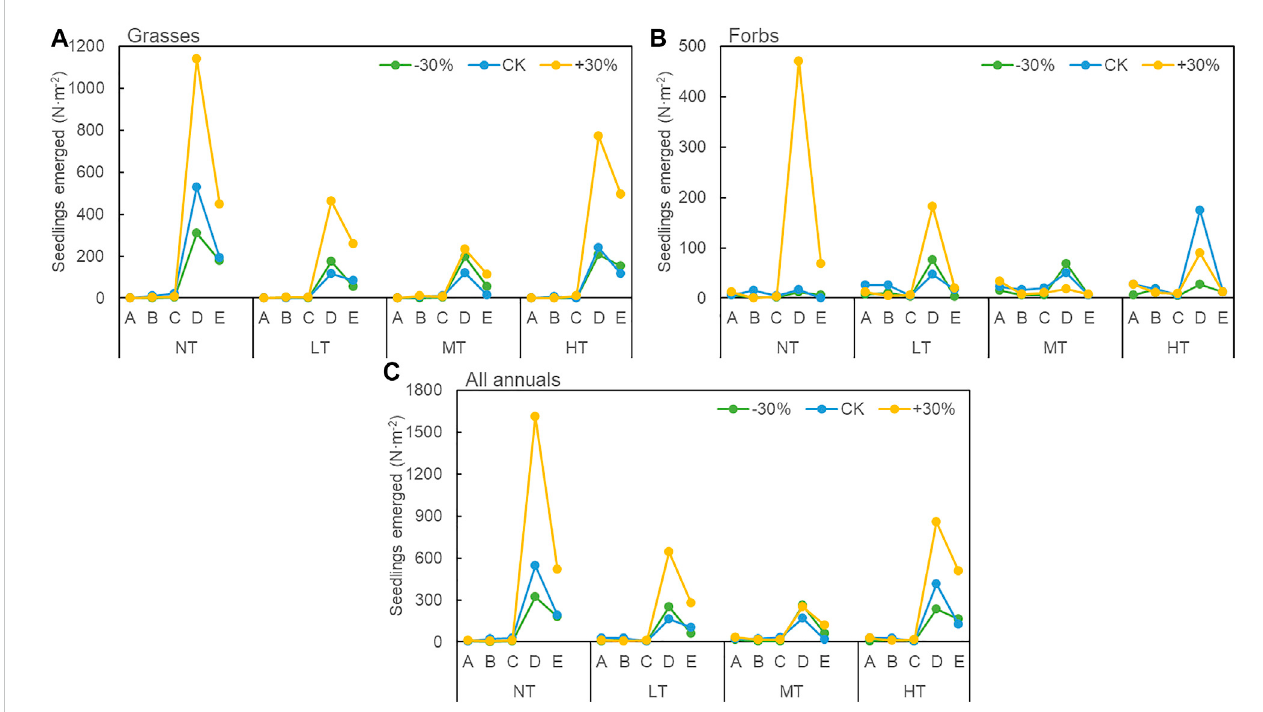
FIGURE 2 Temporaldynamicsofseedlingemergencewithprecipitationvariationunderdifferenttramplingintensities.Seedlingemergenceofgrasses (A) ;Seedling emergence of forbs (B) ; Seedling emergence of all annuals (C) . NT, no trampling; LT, light trampling; MT, moderate trampling; HT, heavy trampling. A, mid- April; B, the begin of May; C, mid-May; D, the begin of June; E, mid-June. − 30%, decreased precipitation by 30%; CK, ambient precipitation; +30%, increased precipitation by